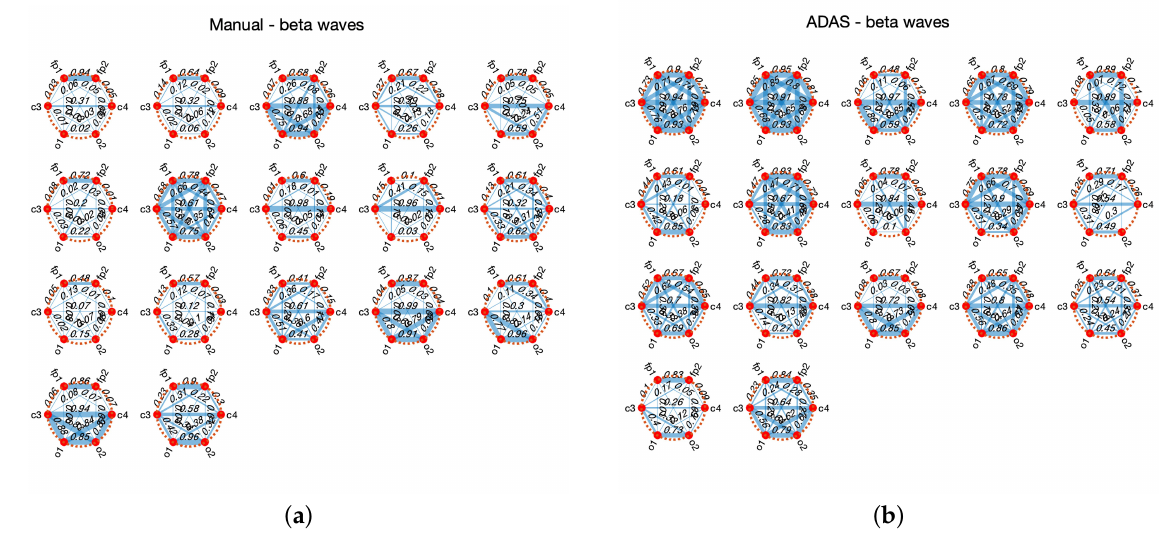
Figure 4. Connectivity networks of subjects 1–17. The thicker lines are associated with higher correlation. ( a ) Manual, beta waves; ( b ) ADAS, beta waves.